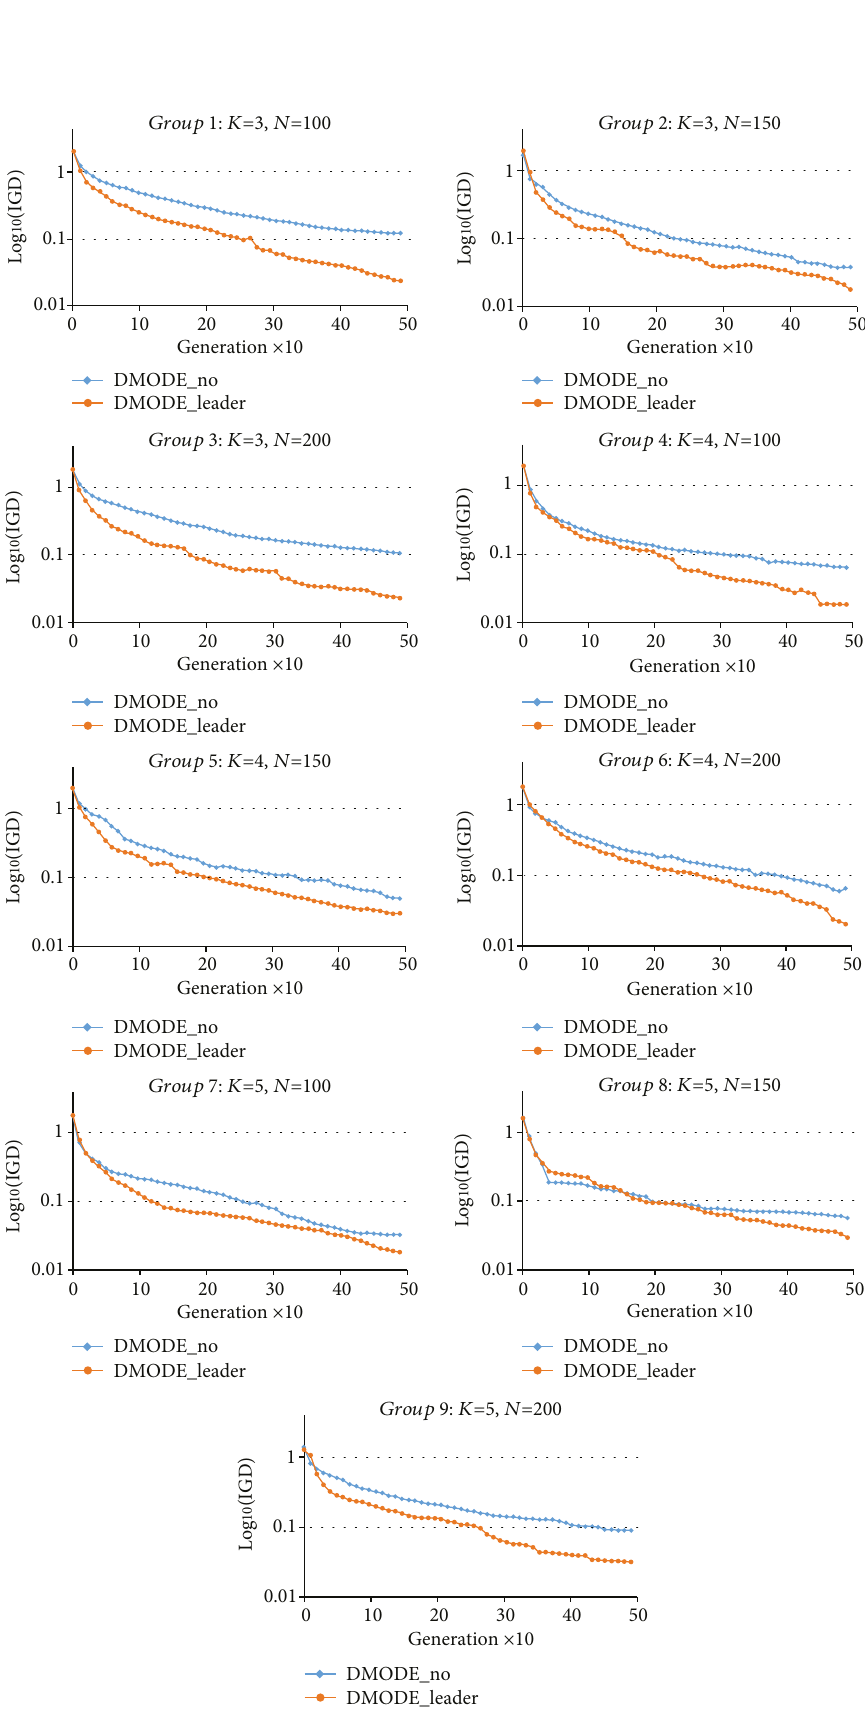
Figure 9: Evolution process of the IGD metric for the two